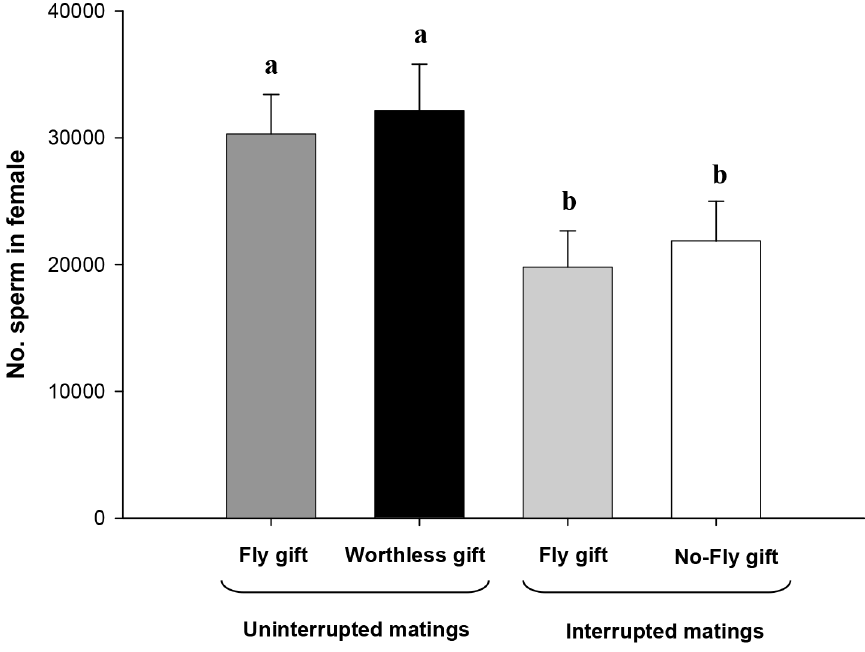
Fig 2. Number of sperm in female spermathecae in uninterrupted matings: Fly gift-uninterrupted mating, males offering a fly gift and Worthless gift-uninterrupted mating, males offering a worthless gift; and in interrupted matings: Fly gift-interrupted mating, males offering a fly gift and performing one pedipalp insertion, No-fly gift-interrupted mating, males offering no gift and performing one pedipalp insertion. Data are shown as Means ± SE; different letters indicate significant differences (p < 0.05; Table 1).